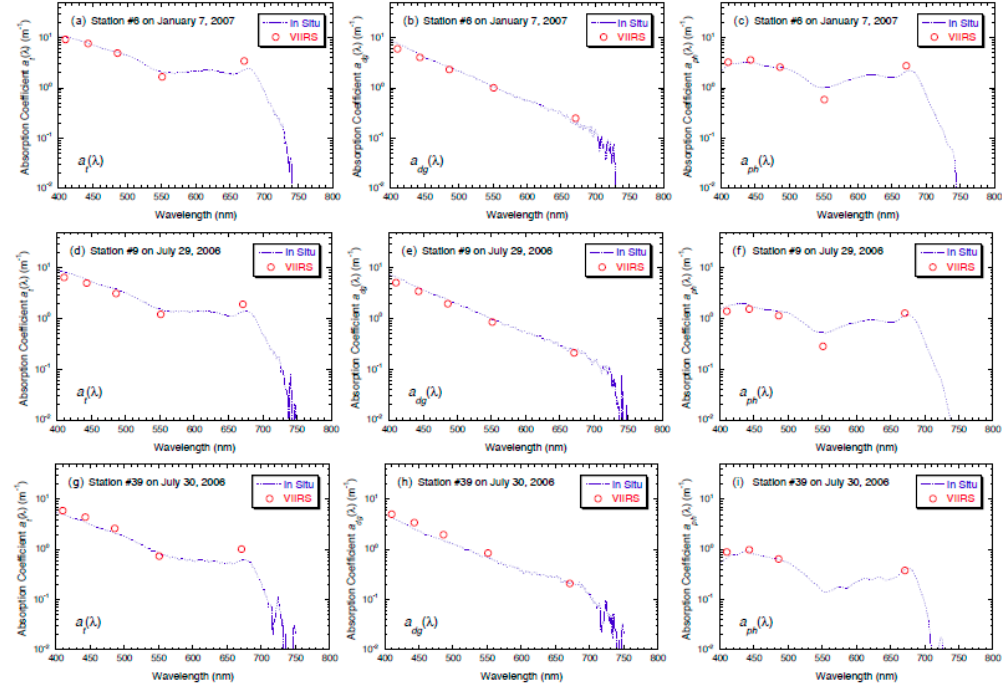
Figure 4. Spectra of the retrieved and in-situ a t ( λ ), a dg ( λ ), and a ph ( λ ) for ( a – c ) at station #06 [31.504 ◦ N, 120.179 ◦ E] on 7 January 2007, ( d – f ) at station #09 [31.506 ◦ N, 120.146 ◦ E] on 29 July 2006, and ( g – i ) at station #39 [31.064 ◦ N, 120.036 ◦ E] on 30 July 2006.